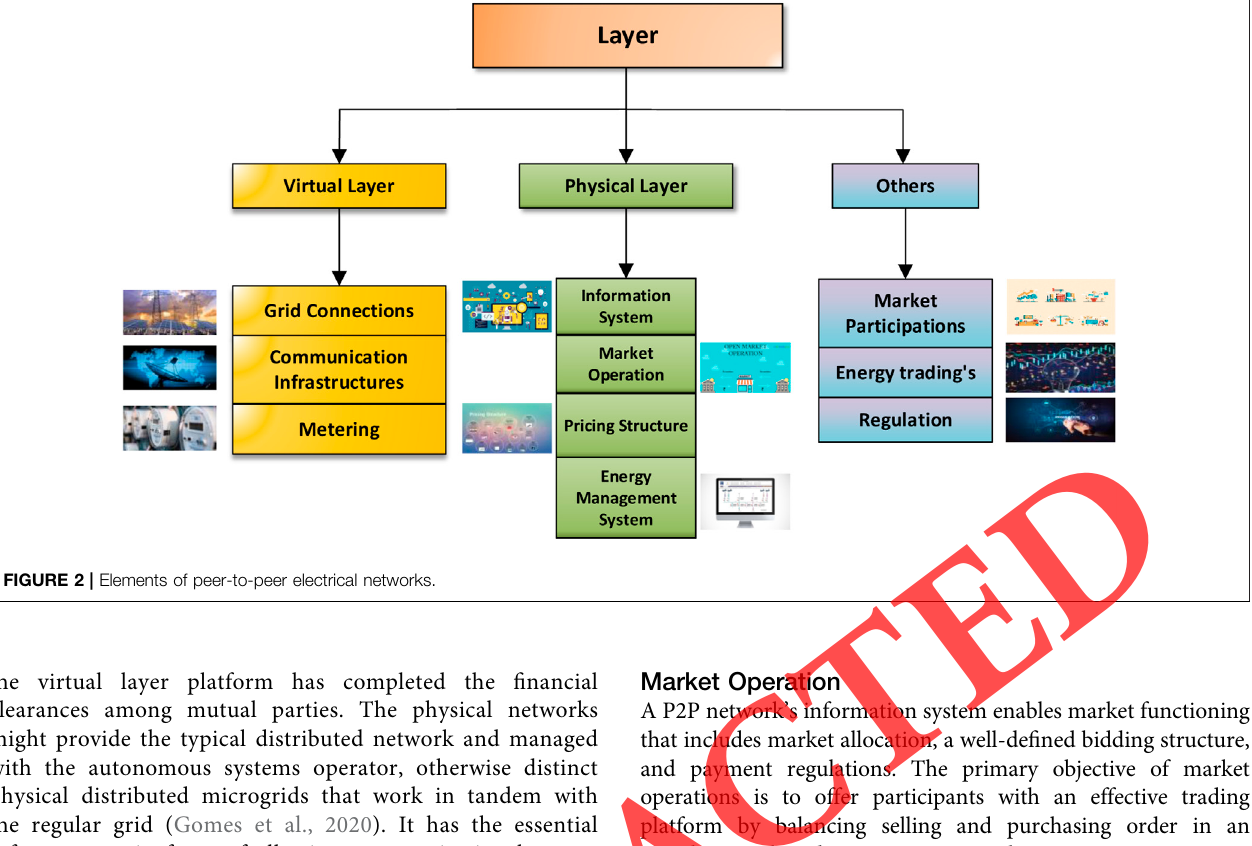
FIGURE 2 | Elements of peer-to-peer electrical